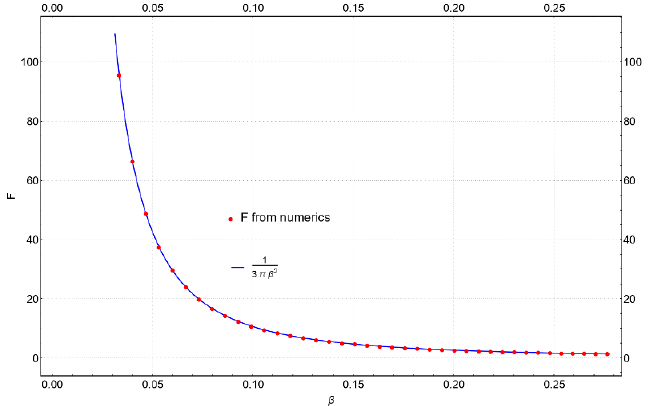
Figure 10 . F ( (cid:26) ) for the black hole solutions in the small- (cid:26) region, in units of (cid:31) , compared to